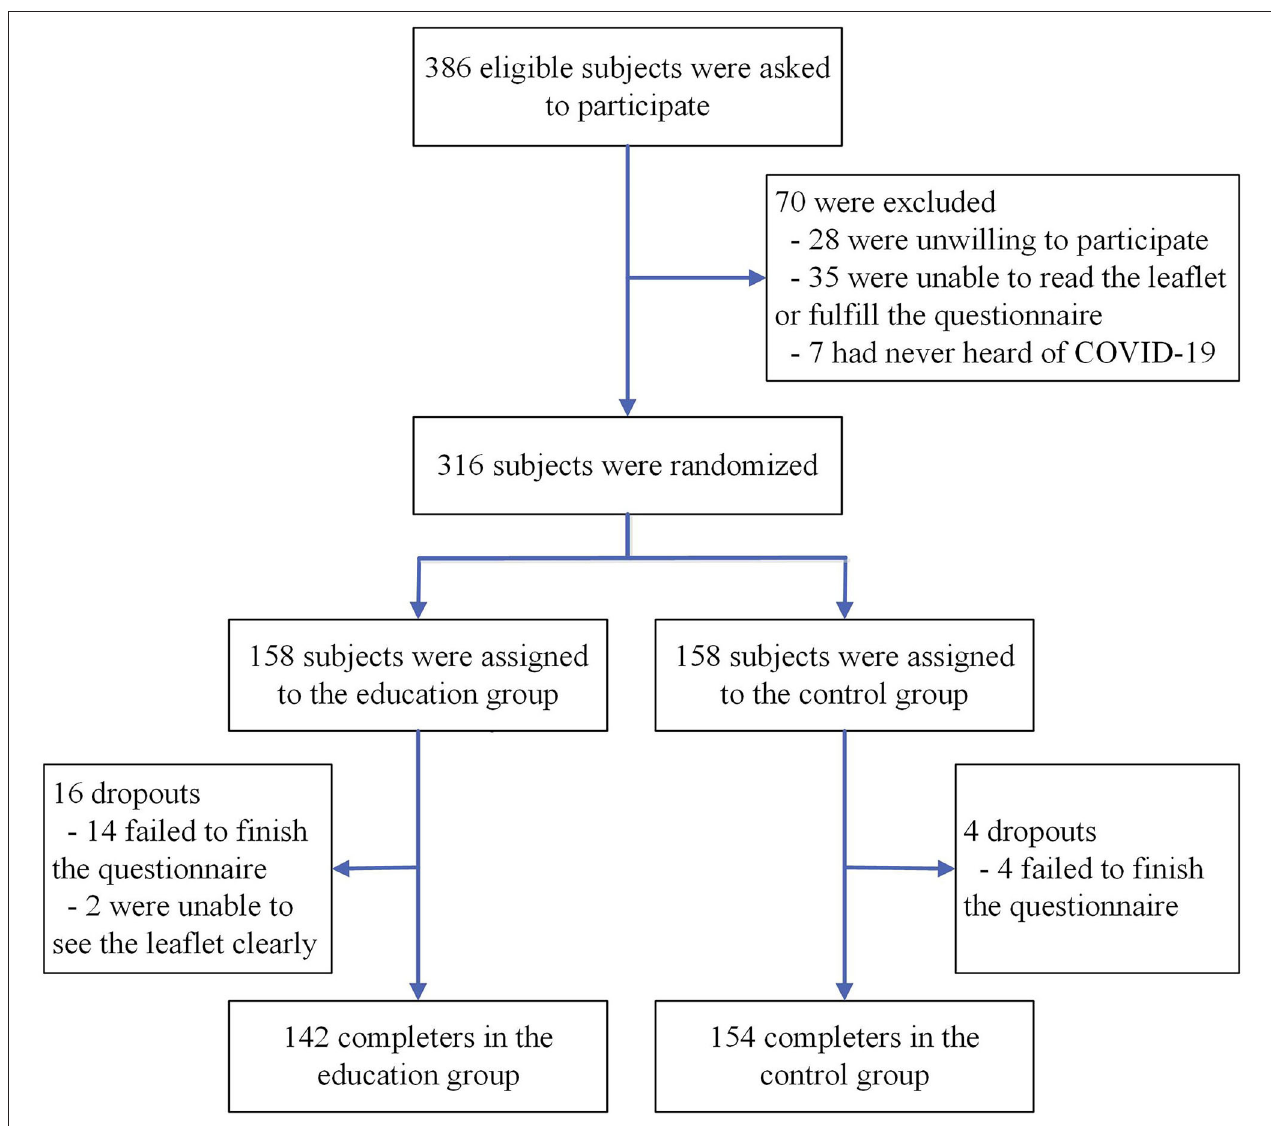
FIGURE 1 | Inclusion flow